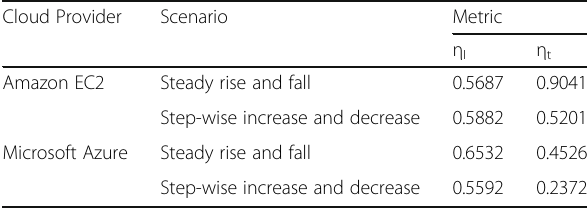
Table 4 Scalability metrics values Cloud